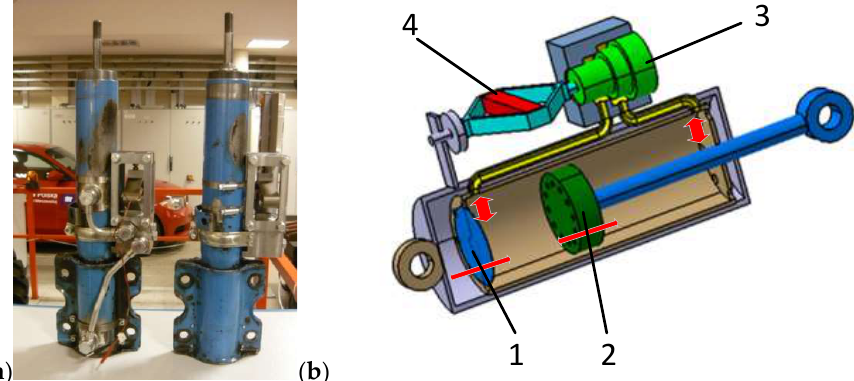
Figure 1. PZD-FT damper: ( a ) PZD-FT damper based on OEM damper design, ( b ) PZD-FT damper diagram: 1—bottom valve, 2—piston with valves, 3—PZV valve, 4—piezoelectric actuator.